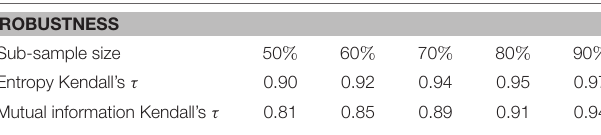
TABLE 1 | Kendall’s τ between the full sample and the bootstrapped sub-samples for different sizes.